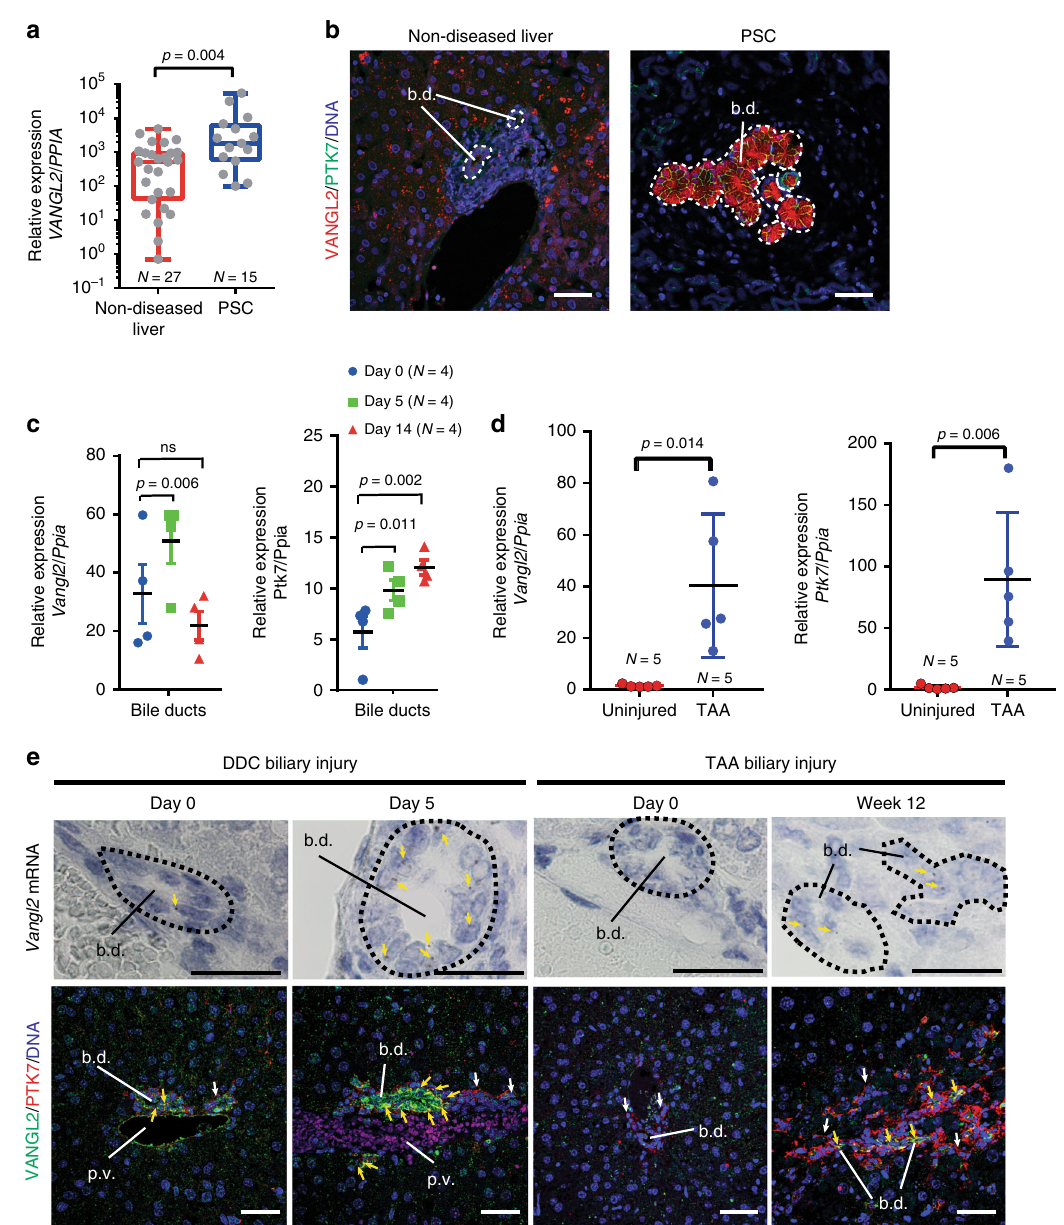
Fig. 4 Wnt-PCP receptors are expressed by regenerating bile ducts. a mRNA expression of VANGL2 in healthy liver tissue and tissue from patients with primary sclerosing cholangitis. b Immuno fl uorescence of VANGL2 (red) and PTK7 (green) in tissue from healthy liver and patients with primary sclerosing cholangitis. Dotted lines denote bile ducts. c mRNA expression of Vangl2 and Ptk7 normalised to Ppia in isolated bile ducts and whole liver from DDC- induced ductular regeneration. d mRNA expression of Vangl2 and Ptk7 in animals with TAA-induced biliary injury normalised to Ppia . e Upper panels: RNAScope of Vangl2 mRNA in DDC and TAA-induced bile duct regeneration (yellow arrows denote positivity and dotted lines denote bile ducts). Lower panels: immunohistochemistry for VANGL2 (green) and PTK7 (red) in healthy bile ducts, or bile ducts injured with either DDC or TAA. White arrows denote PTK7 single positive stromal cells. Yellow arrows denote biliary epithelial cells that express both VANGL2 and PTK7 in biliary epithelial cells. Scale bar = 50 µ m. Source data are provided as a Source Data fi le. In graphs where two groups are included, a Student ’ s t test is used. When comparing multiple groups, a one-way ANOVA with post hoc correction for multiple testing is used. Box – whisker plots represent min – max range of the data. In dot plots, data are presented as mean ± S.E.M. Each data point (N) represents an individual animal or